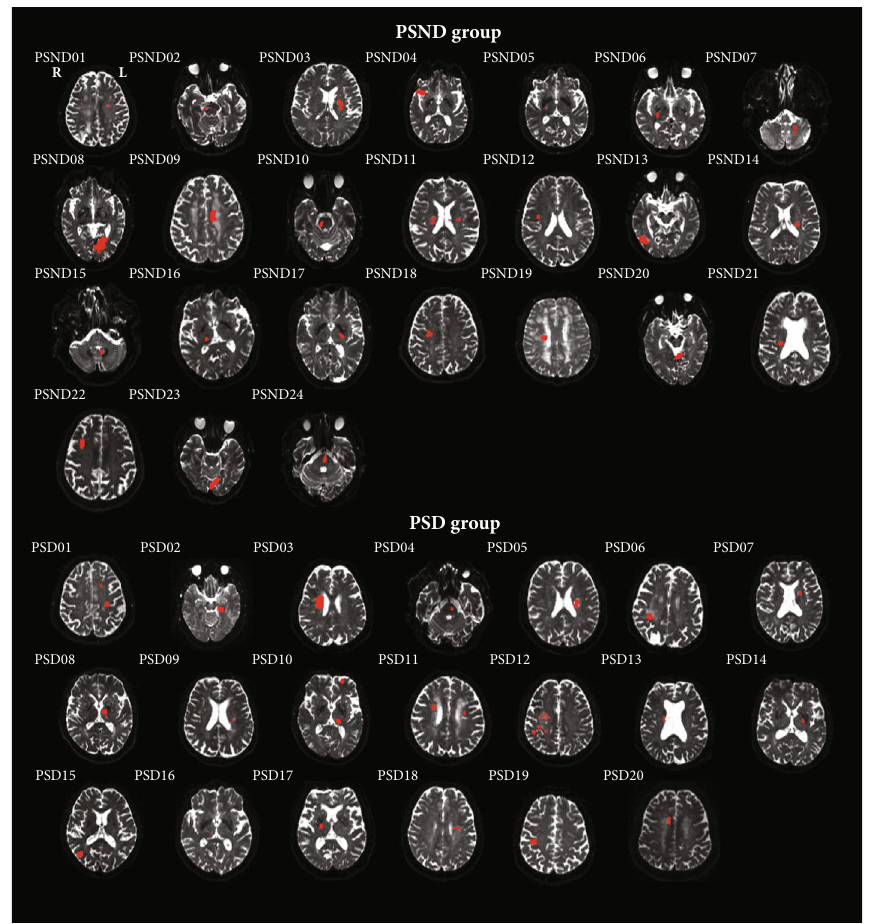
Figure 1: Lesion display for each patient in the PSD and PSND groups. The red region represents an individual